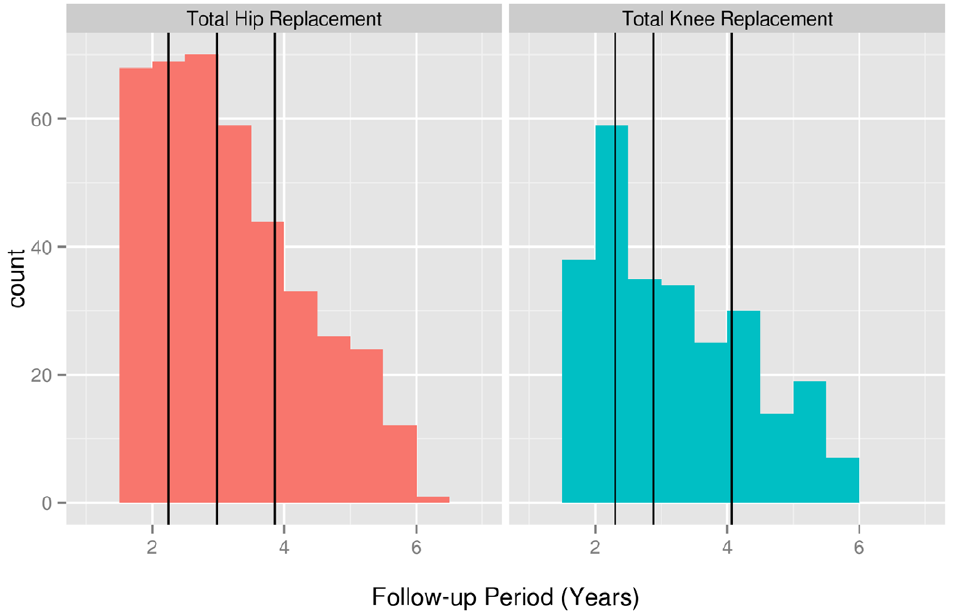
Figure 2. Follow-up Period in Years for THR and TKR patients. Vertical lines indicate quartiles of follow-up period length. doi:10.1371/journal.pone.0056785.g002 PLOS ONE |